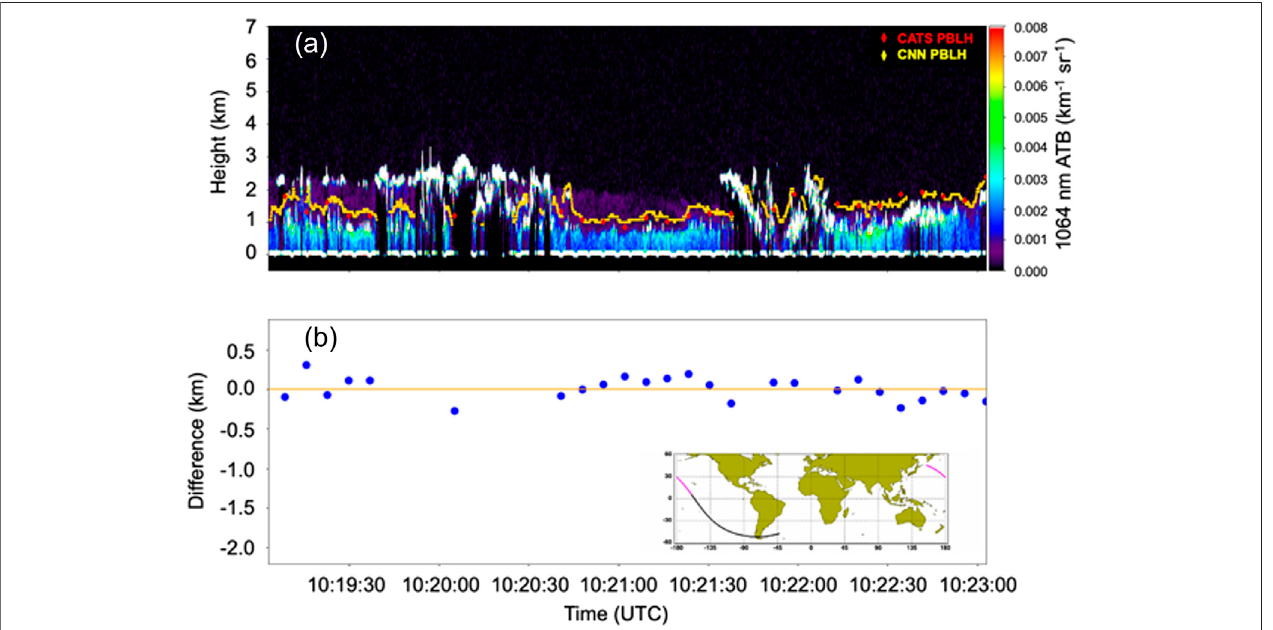
FIGURE 1 | (A) CATS 1064 nm attenuated total backscatter along the track shown in the map inset for June 17, 2015 at roughly 10:21 UTC with the PBL height overlaid from the threshold (red dots) and CNN (yellow dots) techniques. (B) The difference (CNN-threshold) for the two techniques for the same scene.